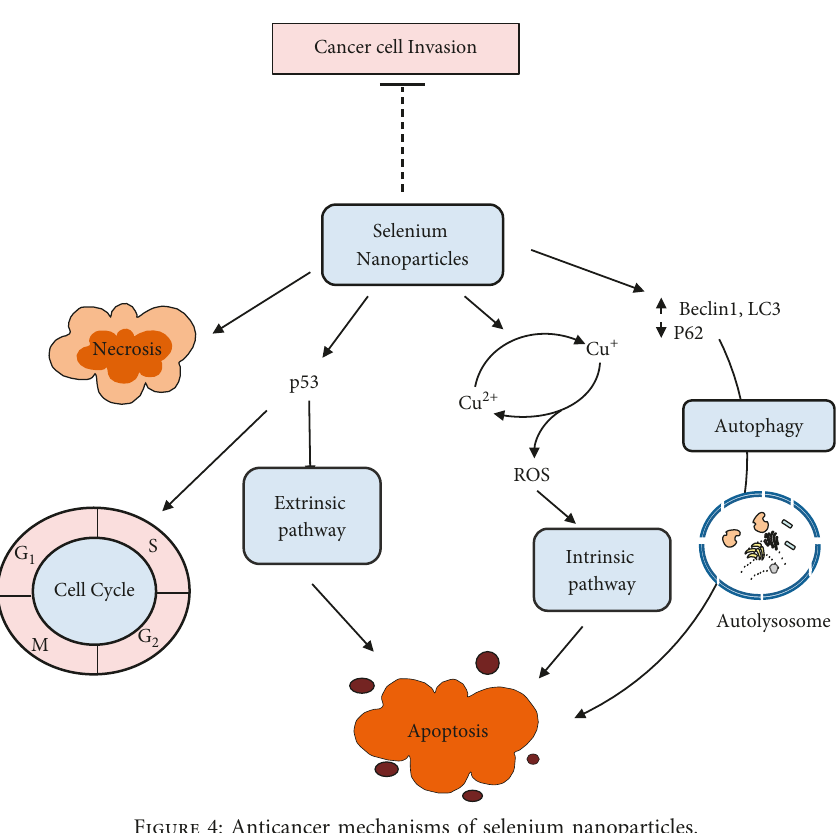
Figure 4: Anticancer mechanisms of selenium